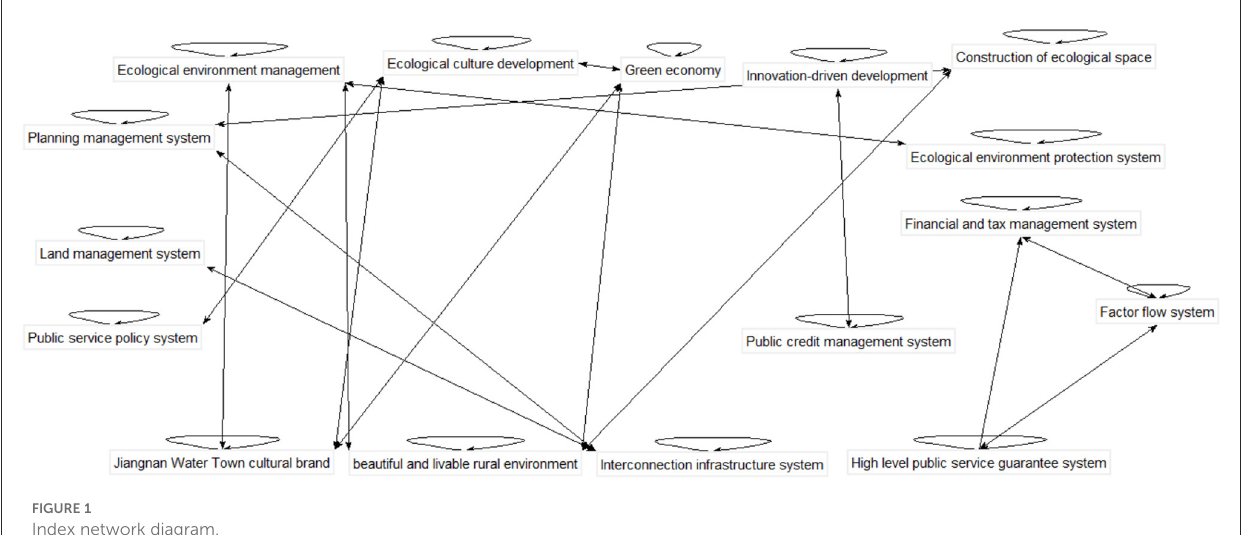
FIGURE1 Index network diagram.